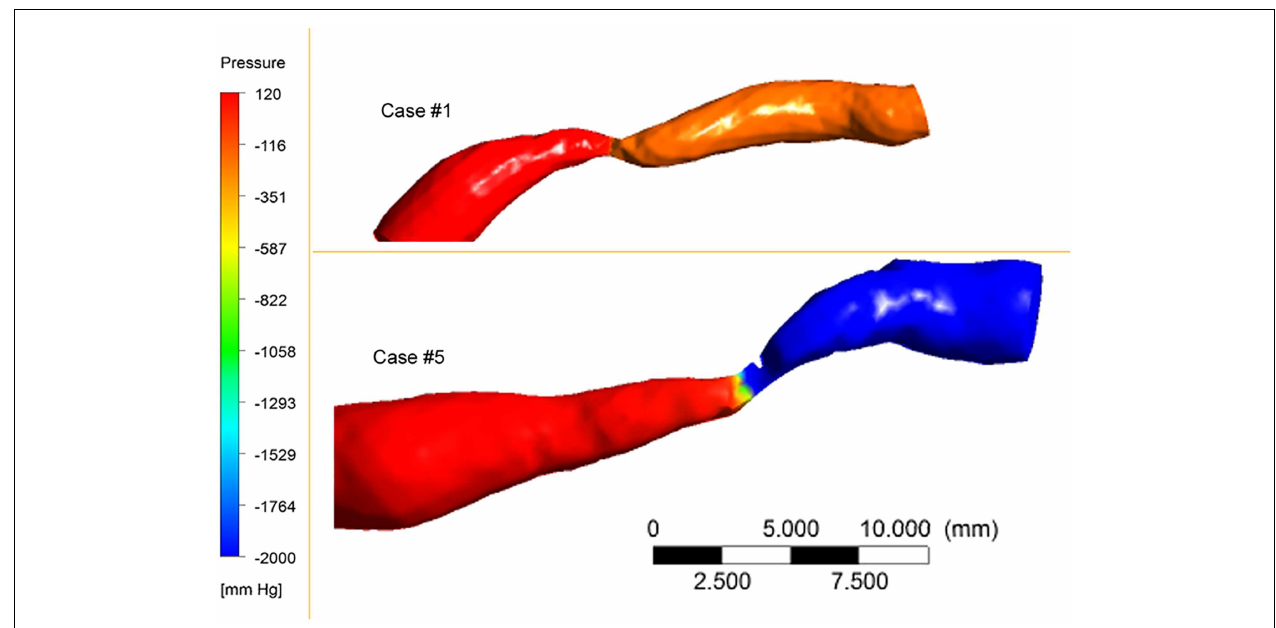
FIGURE 4 | Pressure maps of 80% MCA stenosis . Proximal vessel diameters and lengths of stenosis differ between the cases. Hemodynamic severity of the two cases